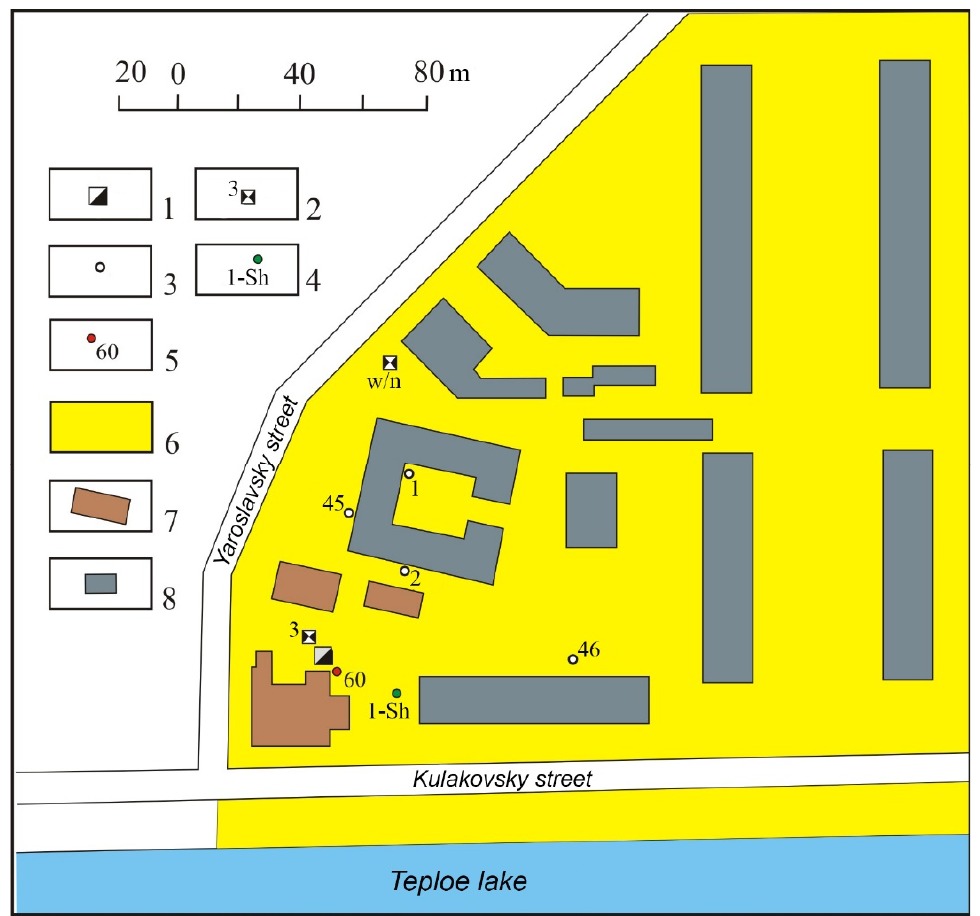
Figure 4. Location of boreholes and test pits: 1—Shergin Shaft and its number in the Inventory of Pre-1965 Boreholes and Test Pits in Yakutsk (compiled based on [31]); 2—test pit and its Inventory number (compiled based on [31]); 3—borehole and its Inventory number (compiled based on [31]); 4—borehole 1-Sh (compiled based on [21]); 5—geocryological monitoring borehole; 6—District B; 7—wooden building; 8—concrete building.